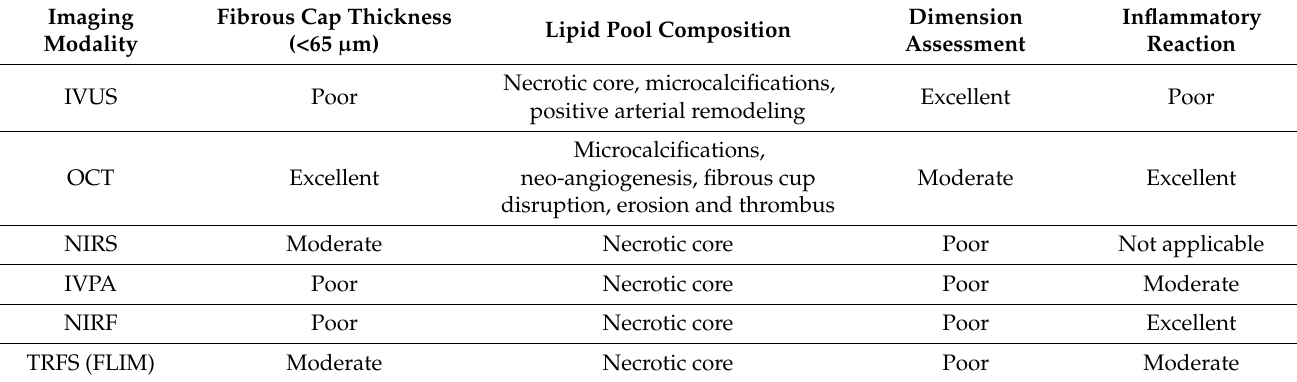
Table 8. Comparison of different intravascular imaging modalities for the assessment of vulnerable plaque.